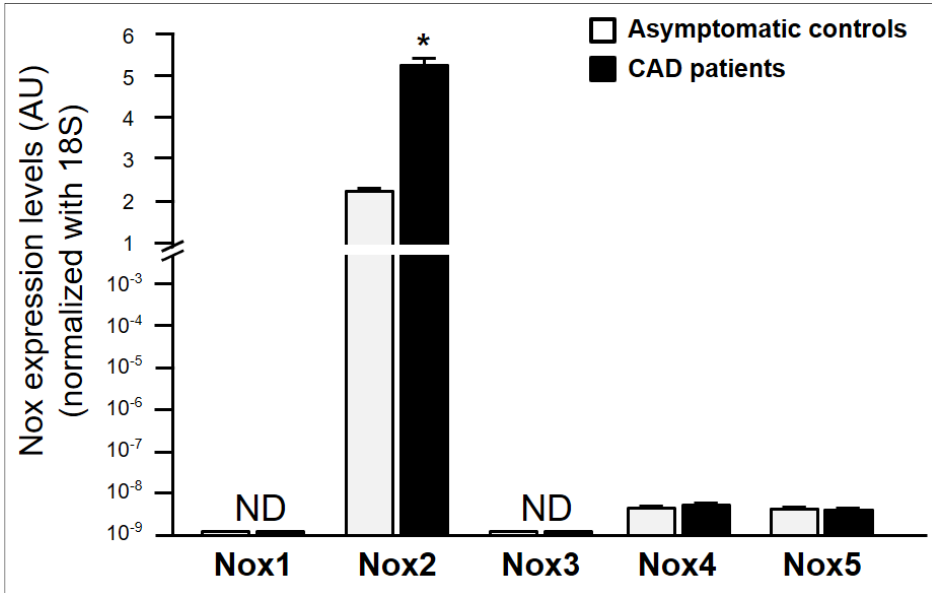
Figure 4. NADPH oxidase subunits Nox1, Nox2, Nox3, Nox4 and Nox5 mRNA levels in peripheral blood mononuclear cells from asymptomatic individuals ( n = 147) and in CAD patients ( n = 25). * p < 0.05 compared with control subjects. CAD, coronary artery disease; AU, arbitrary units; ND, non-detected. Nox, NADPH oxidase.